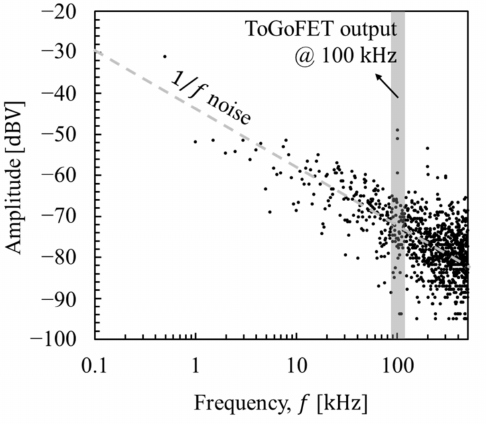
Figure 14. The ToGoFET signal in the frequency domain after the signal passed through the I - V